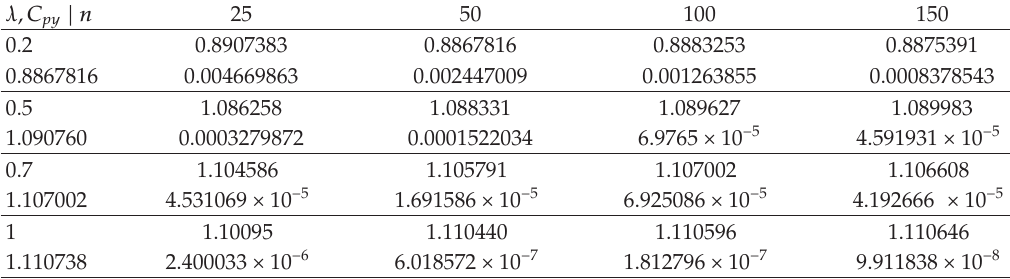
Table 4: Bayes Estimates of C distribution.